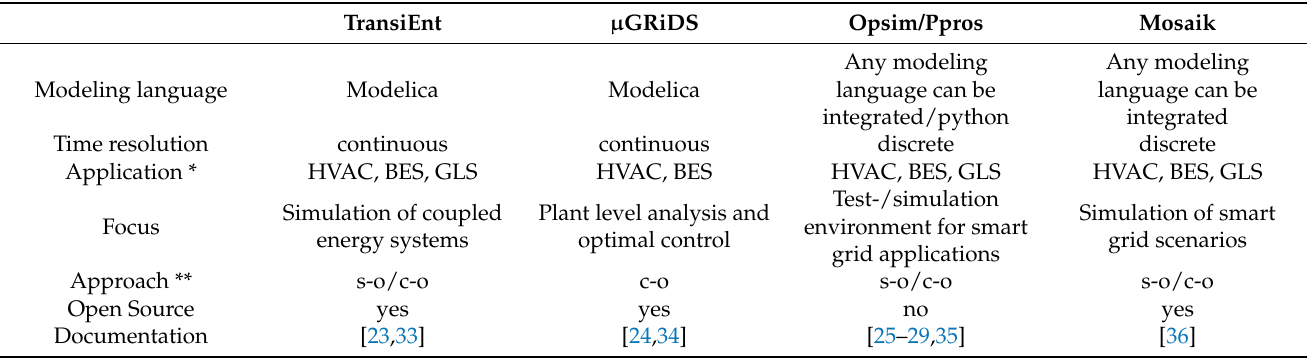
Table 2. Overview of the contributing models.